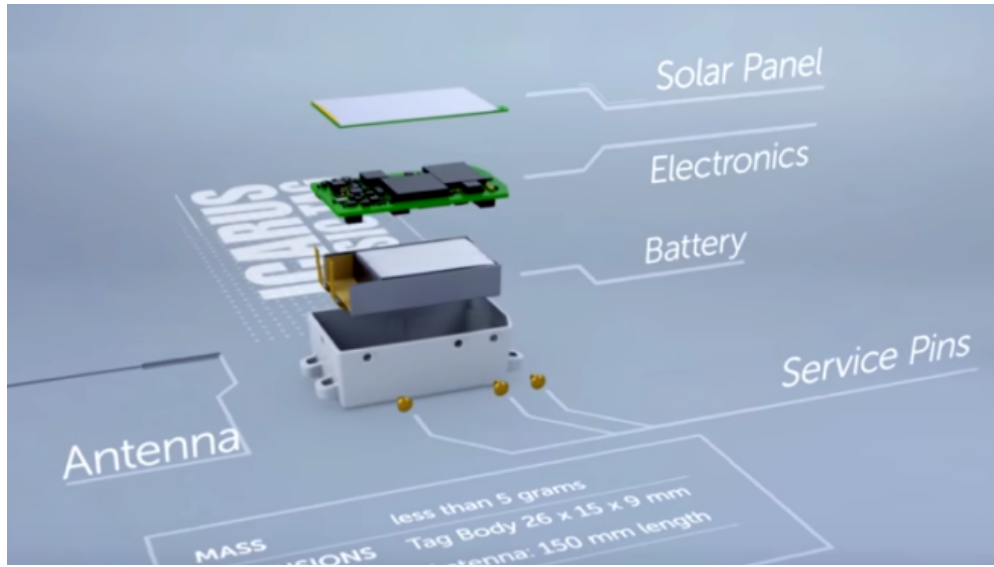
Figure 1. A 5gr ICARUS animal tag with GNSS, accelerometer, magnetometer, temperature sensor, and 500 MB memory. Credit: Max Planck